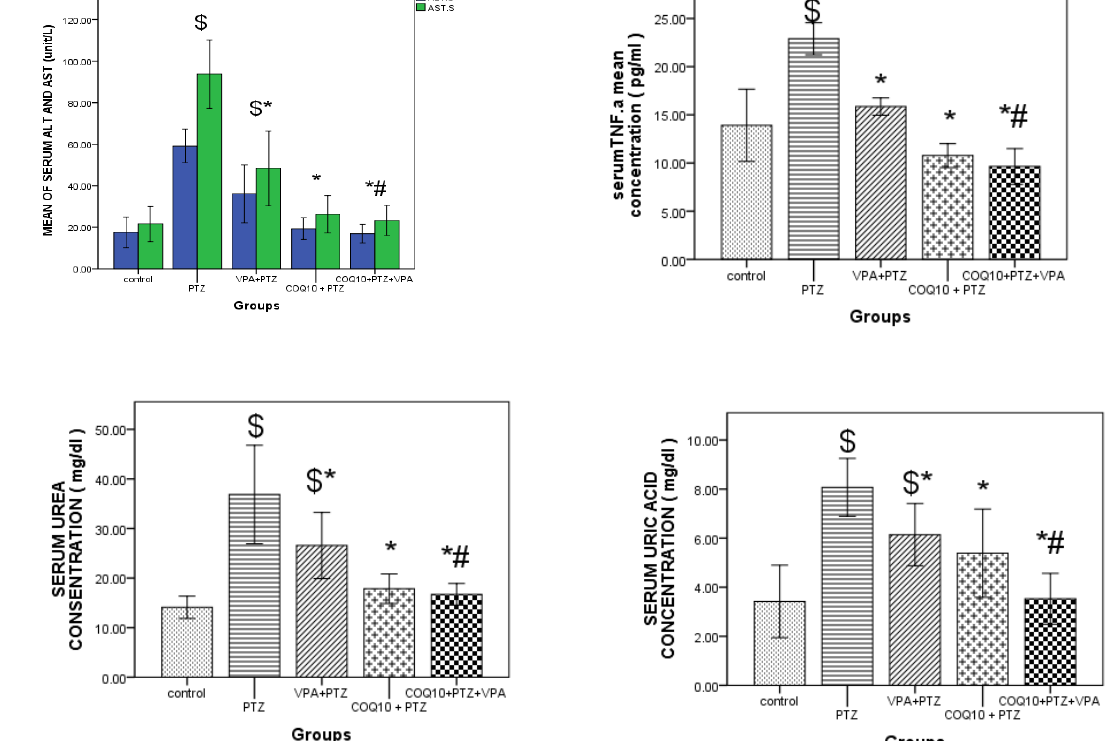
Figure 5. Effect of CoQ10 on liver ALT, AST, and TNF. Pictured are the uric acid and urea of the PTZ/VPA ‐ treated rats. The data are expressed as the mean ± the standard error of the mean, one ‐ way ANOVA, and a post hoc Tukey’s test. ALT: Alanine aminotransferase AST; Aspartate aminotransferase; CoQ10: Coenzyme Q10; PTZ: Pentylenetetrazole; VPA: Valproic acid; TNF.a: tumor necrosis factor. $ p < 0.05, compared to group I (control); * p < 0.05, compared to the PTZ ‐ alone group; # p < 0.05 for the PTZ/VPA + CoQ10 group compared to the PTZ/VPA group.